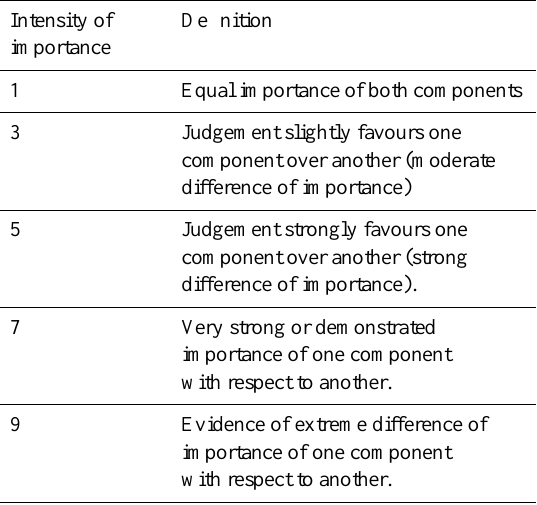
Table 1. The fundamental scale of absolute numbers (“Saaty scale”, adapted from Saaty,